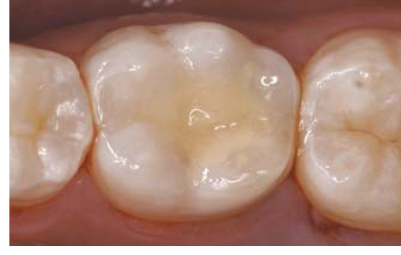
FIGURE 5- Dressing of cavity floor with calcium hydroxide paste directly over the